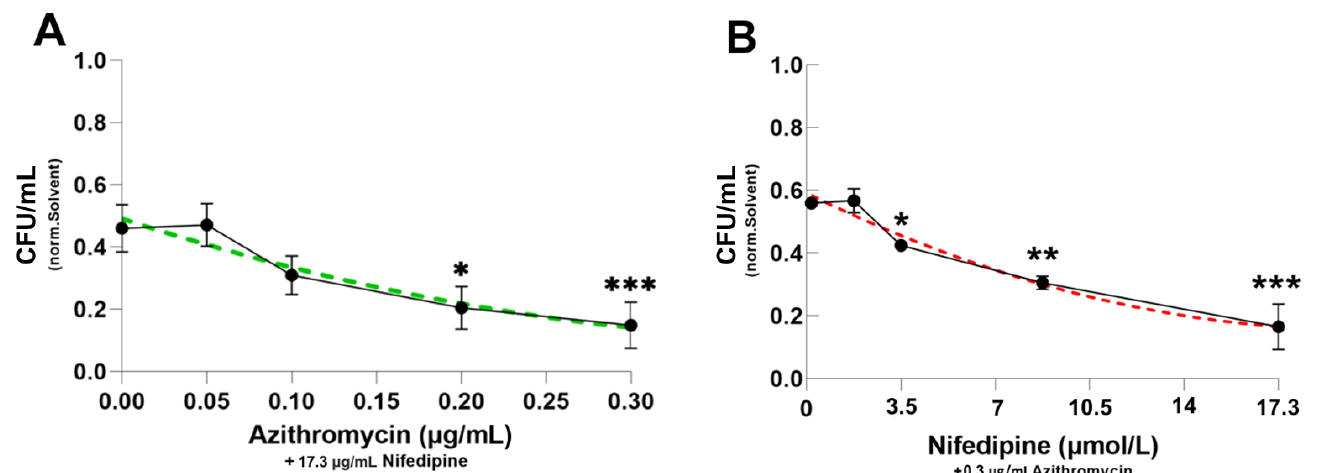
Figure 2. Dose-response curves of nifedipine and azithromycin. RAW264.7 cells were infected with Salmonella Typhimurium for 24 h and treated with nifedipine and azithromycin in indicated concentrations. In ( A ) nifedipine concentration was constant at 17.3 µ g/mL, while azithromycin concentrations were between 0 and 0.3 µ g/mL. ( B ) Azithromycin concentration was constant at 0.3 µ g/mL, while nifedipine concentrations were between 0 and 17.3 µ g/mL. Data are expressed as mean ± SEM of at least four independent experiments. Superscripts indicate statistical significance as follows: * p < 0.05, ** p < 0.01, *** p < 0.001.